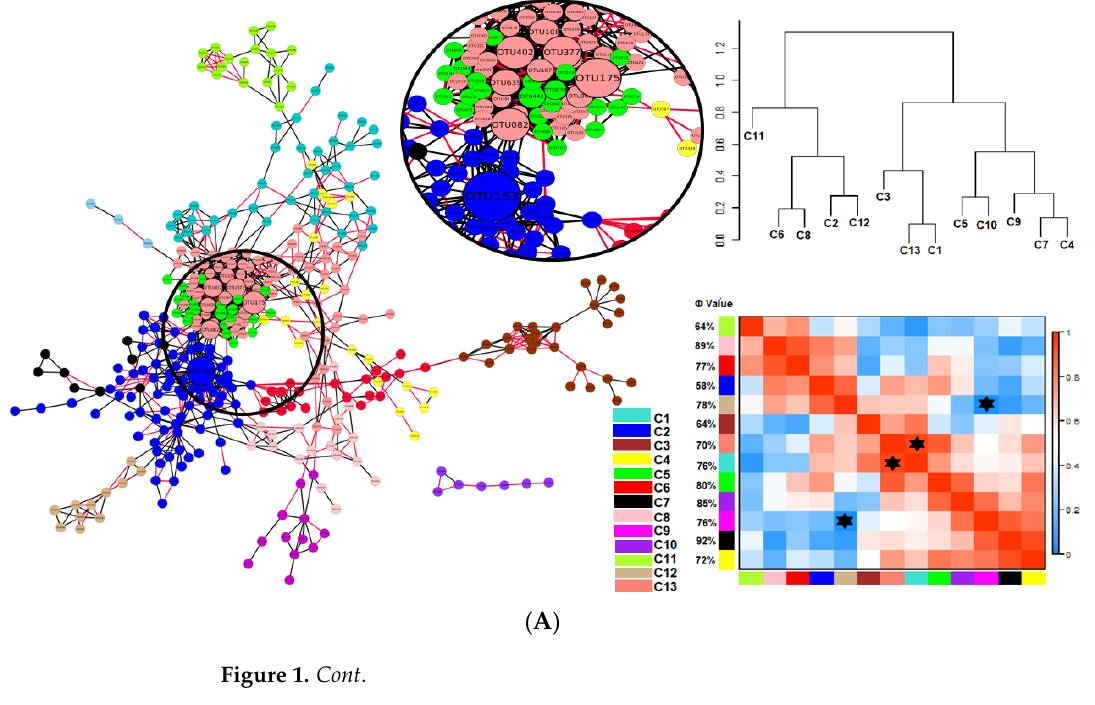
Table 1. Topological properties of the empirical pMENs of microbial communities of the three crop- ping systems and their associated random